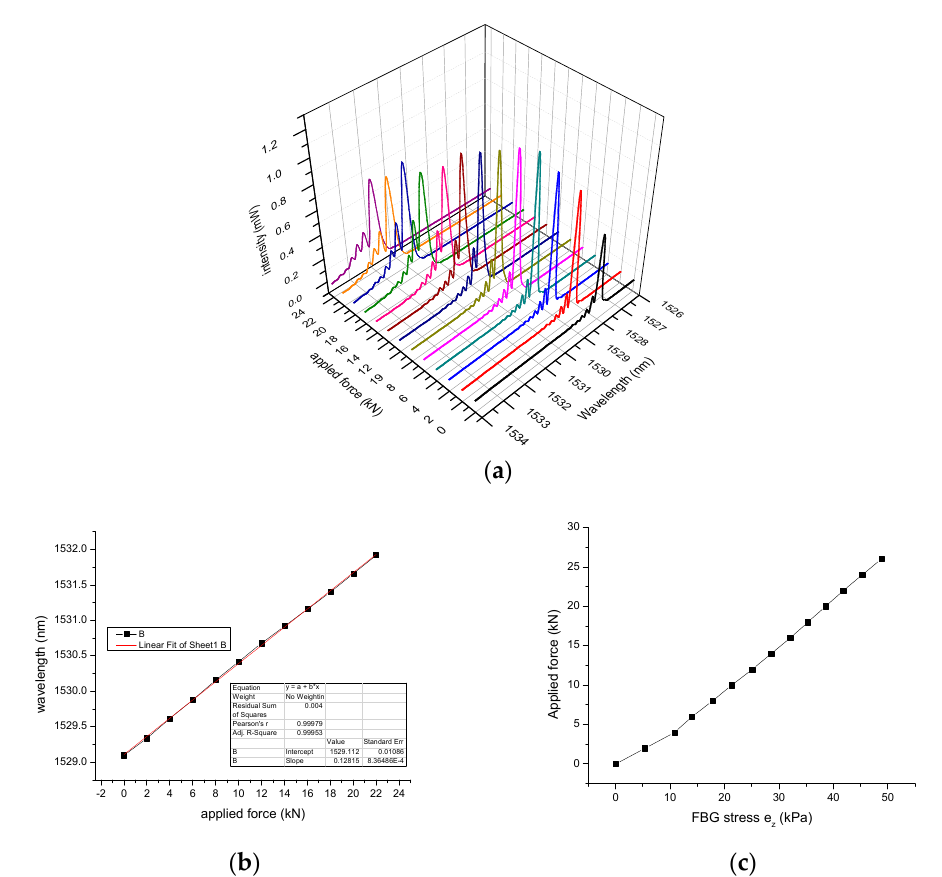
Figure 4. ( a ) 2 mm FBG spectral response with applied force near the crack-tip without composite patch. ( b ) Peak spectral response with applied force. ( c ) Stress on bonded FBG near the crack as a faction of applied force.